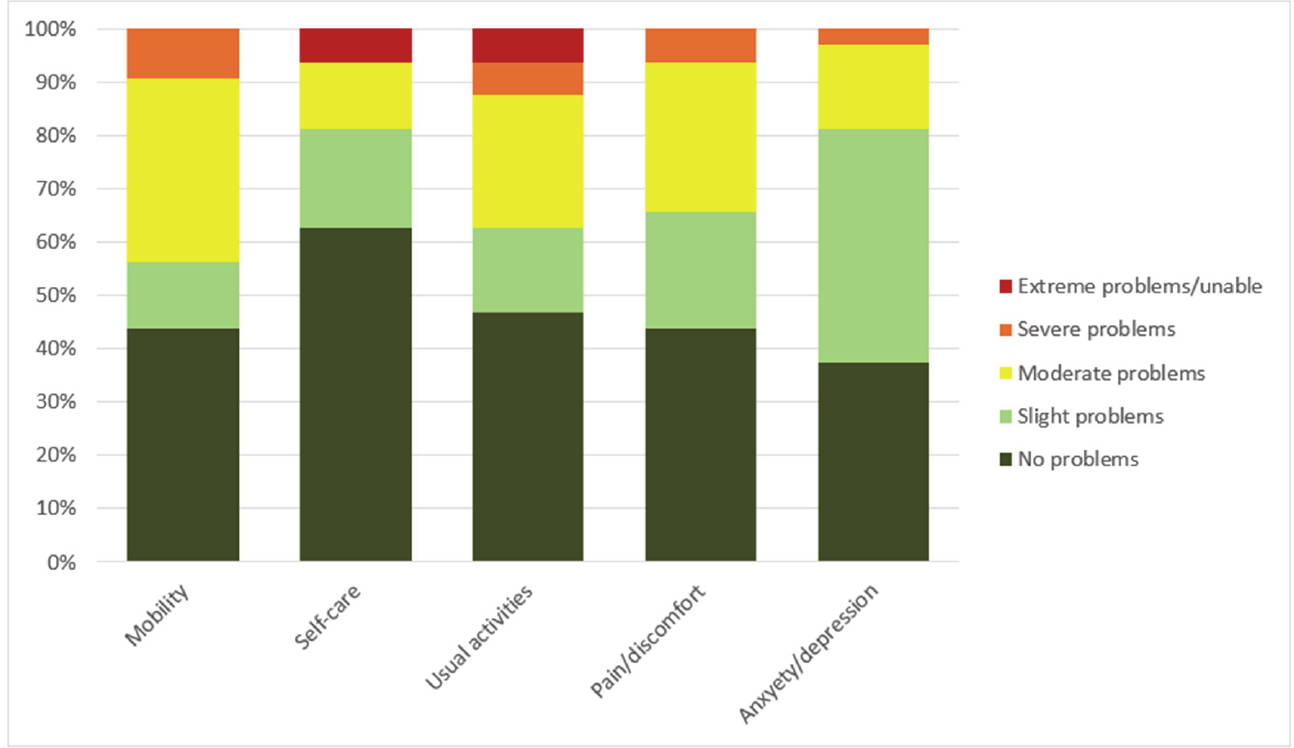
Figure 3. Frequency of severity of problems reported on the EQ ‐ 5D ‐ 5L ( n = 32). Severity of problems represent 5 levels of health as defined by EQ ‐ 5D ‐ 5L descriptive system [24].